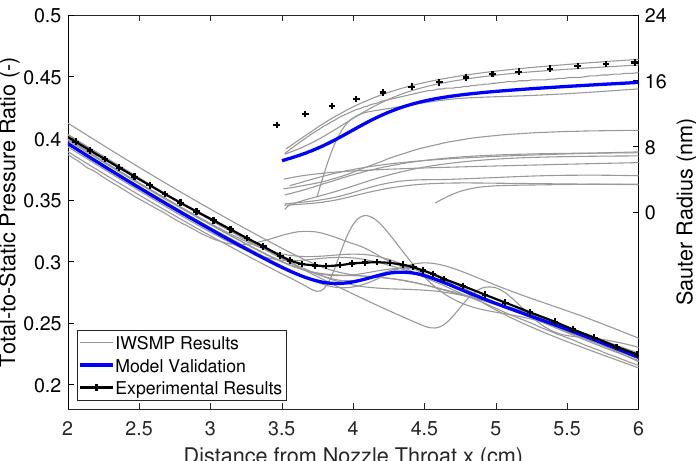
Figure 2. Validation of the nucleation and condensation model with the Moses and Stein nozzle, case 252. Adapted from [12]. Copyright 2022